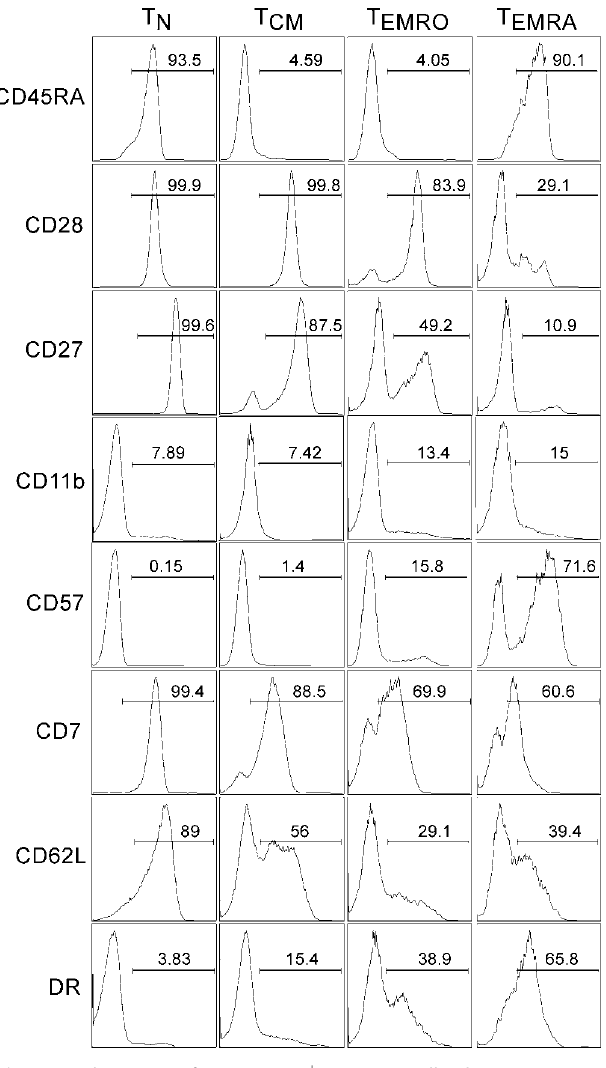
Figure 2. Phenotype of Distinct CD4 þ Human T Cell Subsets Purified CD4 þ T cells were stained with CD45RO and CCR7 in conjunction with the antibodies shown. Electronic gates were set on T N , T CM , T EMRO , and T EMRA cells as described in Figure 1A, and expression of various T cell surface markers was analyzed. A representative profile from an HIV- infected individual is shown. Similar phenotype was observed in all four subsets of T cells from six HIV-infected and HIV-uninfected